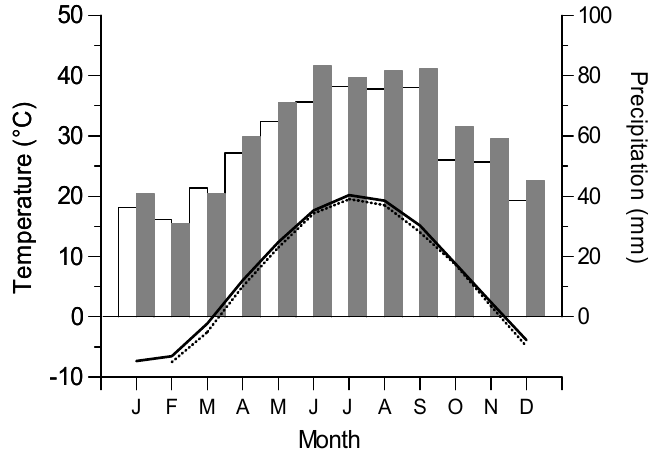
Figure 2. Mean monthly temperature and mean total monthly precipitation were averaged from 1965–2010 for Mio (dashed line, open bars) and Hale Loud Dam (solid line, gray bars), Michigan. The lines represent temperature, and bars represent precipitation.